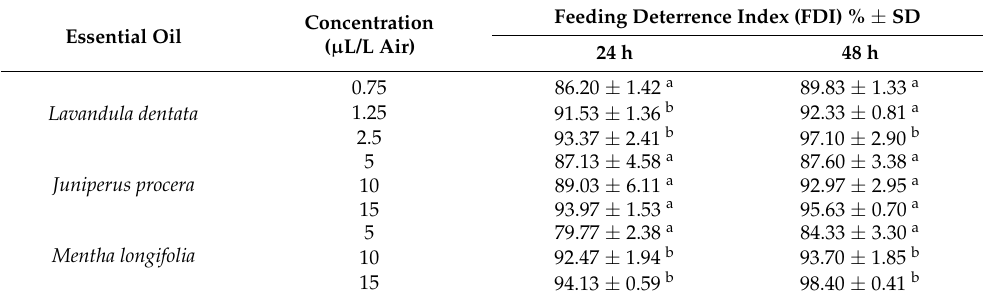
Table 5. Feeding deterrent activity of Lavandula dentata , Juniperus procera , and Mentha Longifolia essential oils against the land snail Monacha obstructa